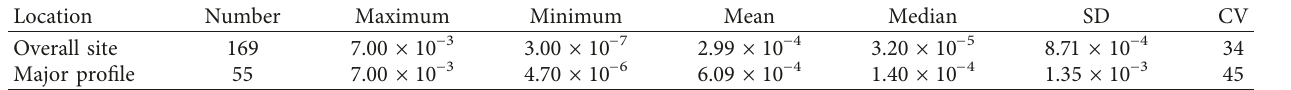
Table 1: Descriptive statistics for the K s value of the slide mass of the Baishuihe landslide.